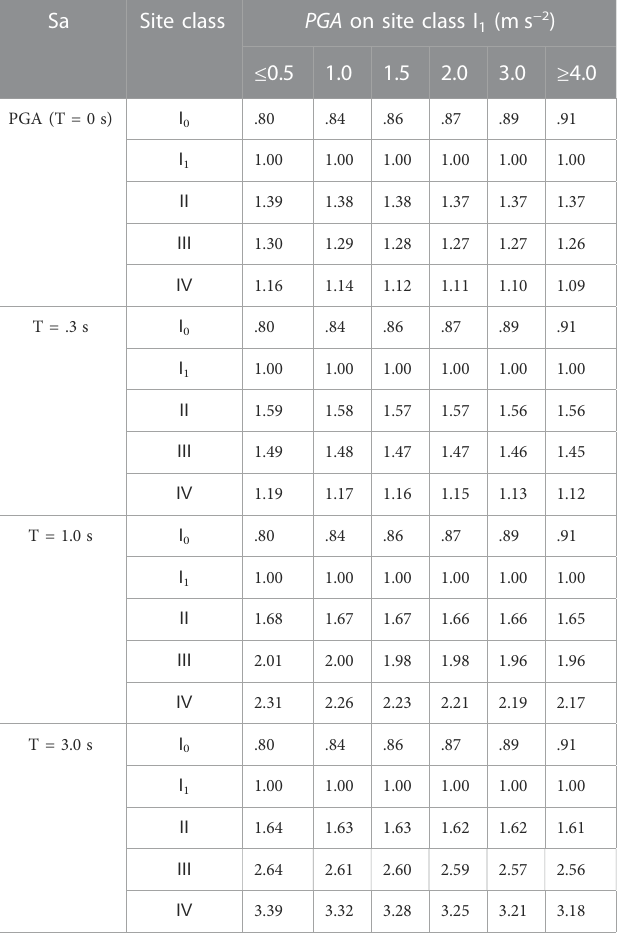
scaling ratios for PGA-normalized Sa, β i ( T ) , were shown in Figures 6C, D, 7C in green curves for i = II, III, or IV, and β